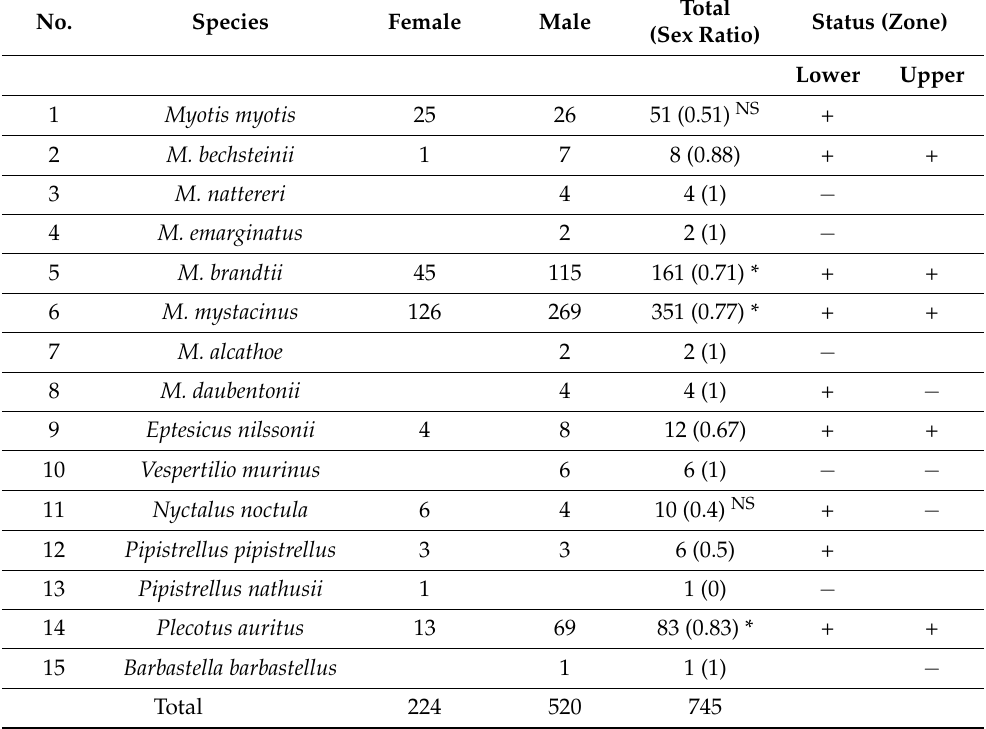
Table 1. Numbers of bats of each species caught in the forests of the Polish Tatra Mountains, 2016–2020. The sex ratio (proportion of males in total) is provided in brackets. Used symbols: * sex ratio significantly different from unity ( p ≤ 0.05), NS sex ratio not significantly different from unity ( p > 0.05), + evidence of breeding (presence of adult lactating females and/or juveniles), − lack of evidence, empty—lack of